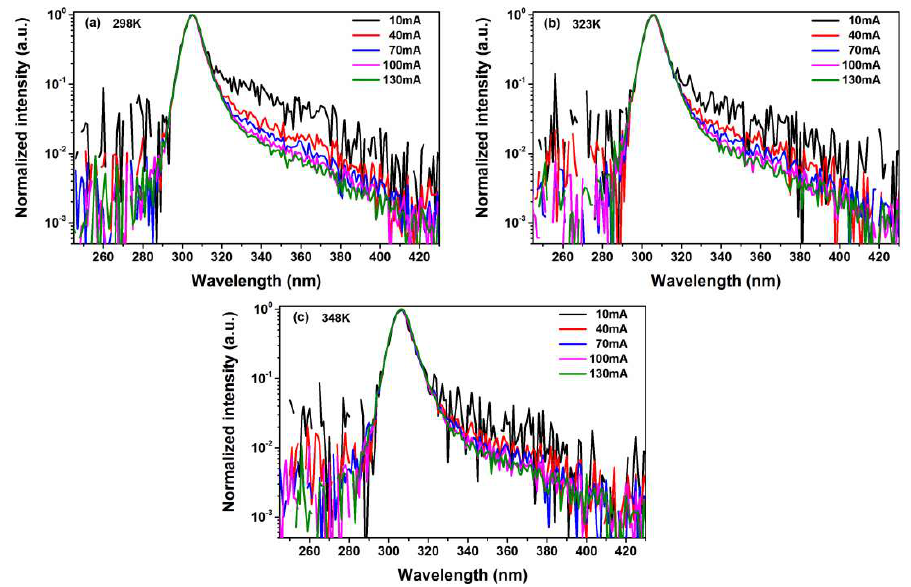
Figure 2. Normalized EL emission spectra of the AlGaN-based UVB-LED, recorded at various forward currents ( a ) 298, ( b ) 323, ( c ) 348 K.